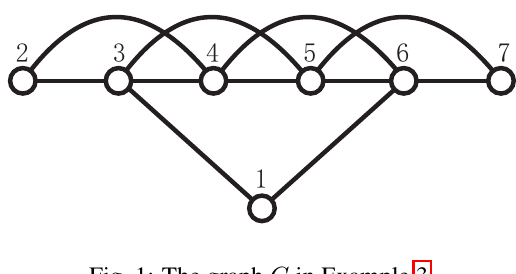
Fig. 1: The graph G in Example